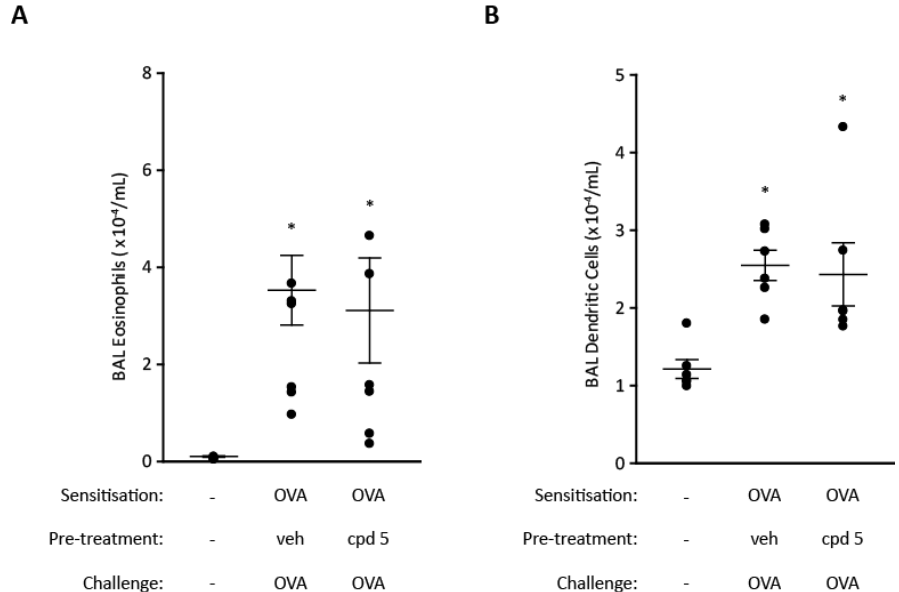
Figure 7. An allergen delivery inhibitor directed against Der p 1 (Compound 5 ) does not affect responses to OVA in OVA-monosensitised Balb/c mice. ( A ) Recovery of CCR3 + eosinophils in BAL fluid of OVA-challenged animals (10 µ g, i.t. aerosol) treated 2 h prior to OVA with saline vehicle or Compound 5 (50 µ g/kg, i.t.) ( B ) Corresponding data for dendritic cells. Cross hairs and whiskers show mean ± s.e. mean. * p < 0.05 vs. control group of unsensitised animals.